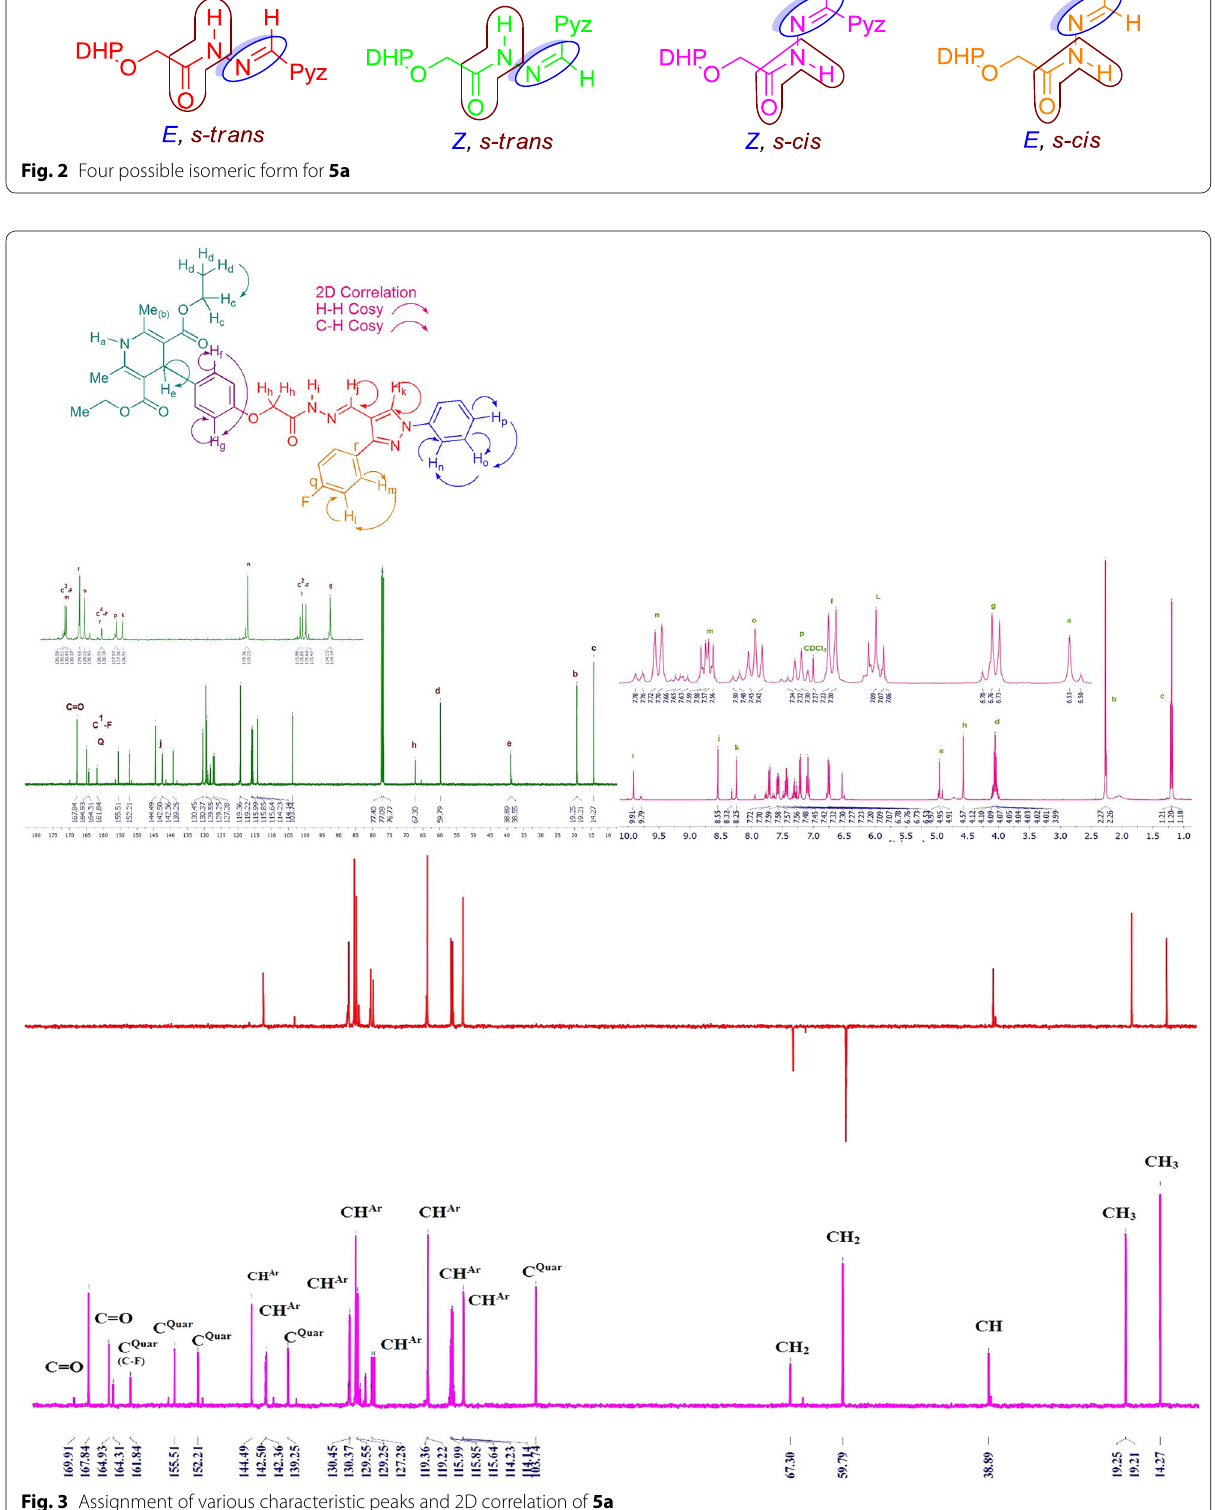
Fig. 3 Assignment of various characteristic peaks and 2D correlation of